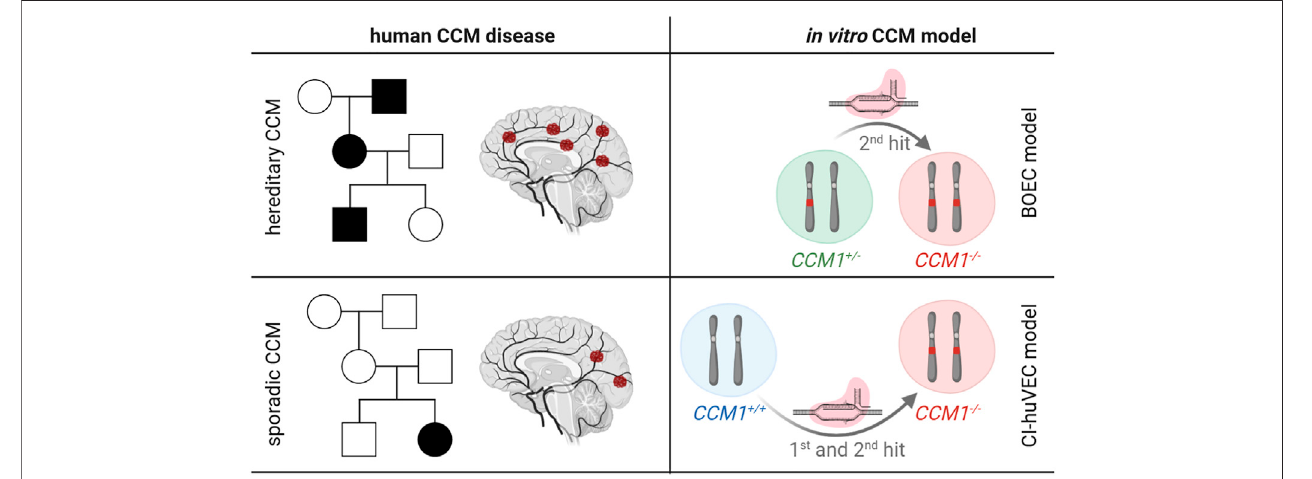
FIGURE 1 | Overview of CCM cell culture models. Features of hereditary and sporadic CCM disease (left subpanels) as well as the CRISPR/Cas9 genome editing approaches that have been used in this study (right subpanels) are schematically depicted (created with BioRender.com). Filled symbols in the pedigrees indicate CCM patients. CCM1 +/+ (cid:2) cells with two CCM1 wild-type alleles ; CCM1 +/ − (cid:2) cells with a heterozygous CCM1 mutation; CCM1 − / − (cid:2) cells with biallelic CCM1